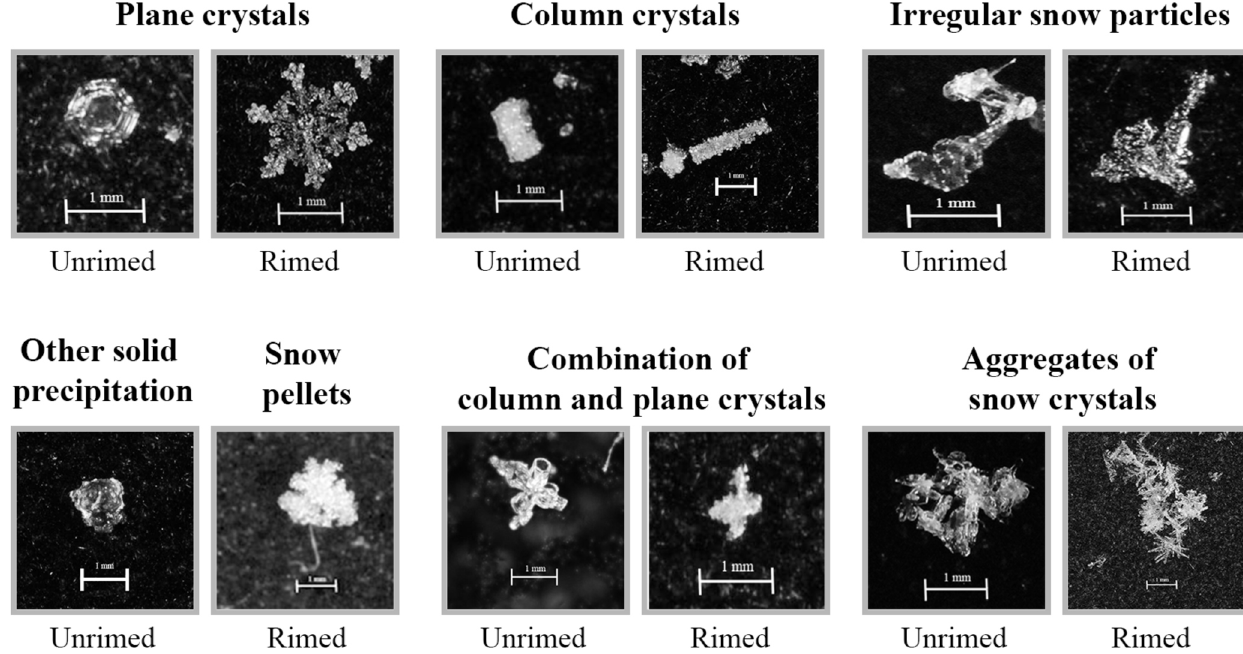
Figure A1. The 12 categories of ice particles utilized in the analysis of the microphotography images. The categories are adapted from Kikuchi et al.